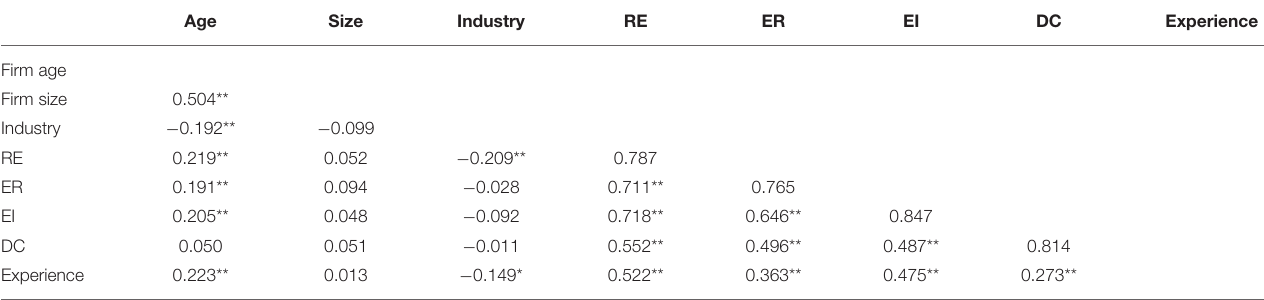
TABLE 2 | Descriptive statistics for the main variables.